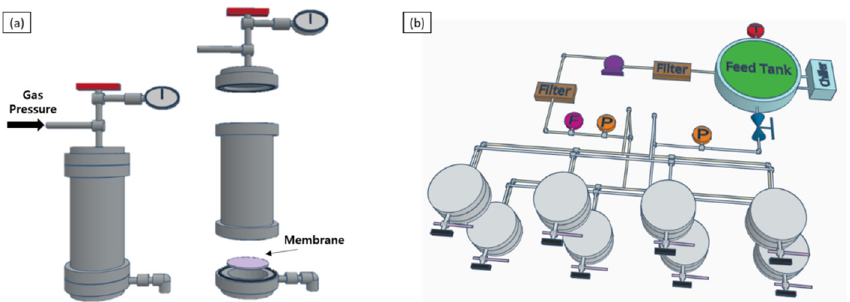
Figure 1. Schematics of ( a ) dead-end cell apparatus, and ( b ) in-house cross-flow system with 8 membrane cells in parallel configuration. The membrane permeance was calculated using the following